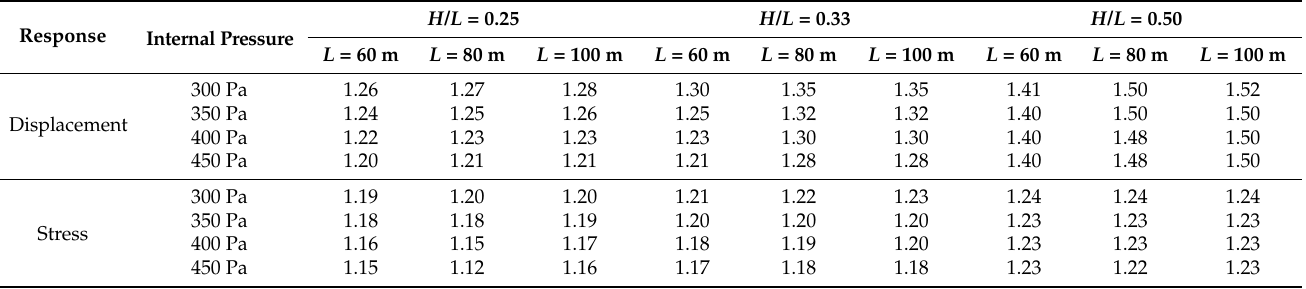
Table 5. Gust response factors for spherical inflatable membrane structures without